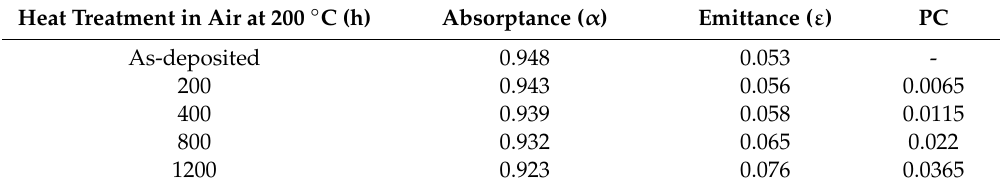
Table 4. The optical characteristics of coating after heat